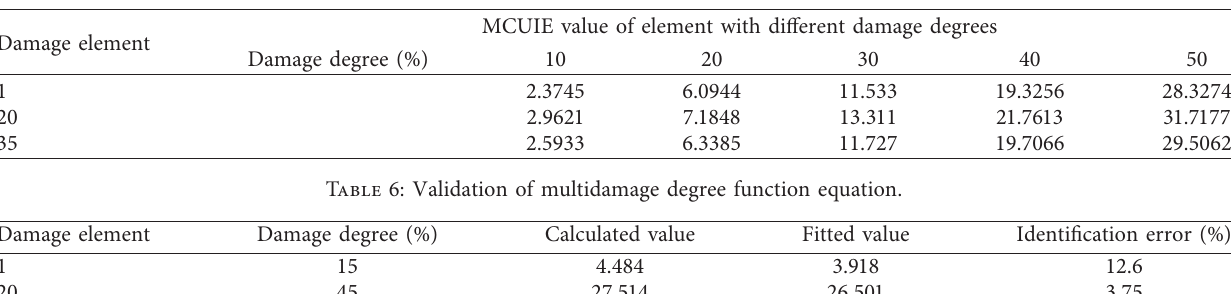
Figure 14: Damage degree fitting curve of single damage. Table 5: MCUIE value of multidamage with different damage degrees.